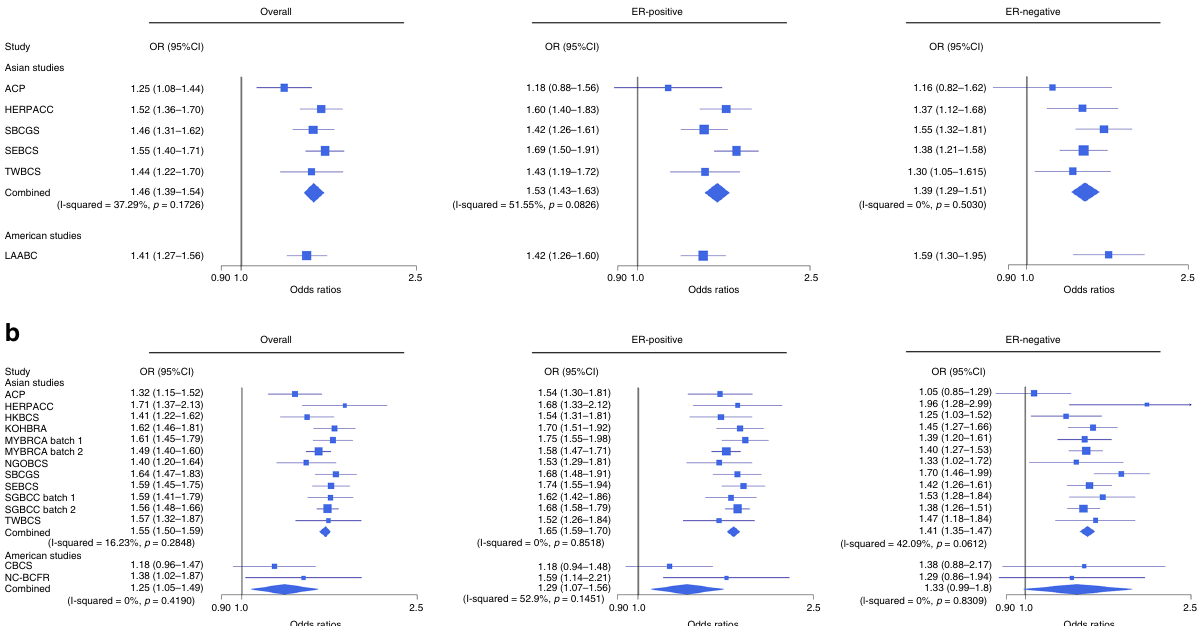
Fig. 1 Association between standardised 287-SNP polygenic risk scores and breast cancer risk. Panel a shows the results for iCogs array by study and panel b shows the results for Oncoarray. The squares represent the odds ratios (ORs) and the horizontal lines represent the corresponding 95% con fi dence intervals. Overall estimates within genotyping array were obtained by combining the estimates across studies using fi xed-effect meta-analysis, represented by the diamond shape. I-squared and p value (two-sided) for heterogeneity were obtained by fi tting a random-effects model and using generalised Q -statistic estimator (the rma() command in R). The sample size of individual studies are listed in Supplementary Table 1. The ORs and corresponding 95% con fi dence intervals are provided as a Source Data fi le.